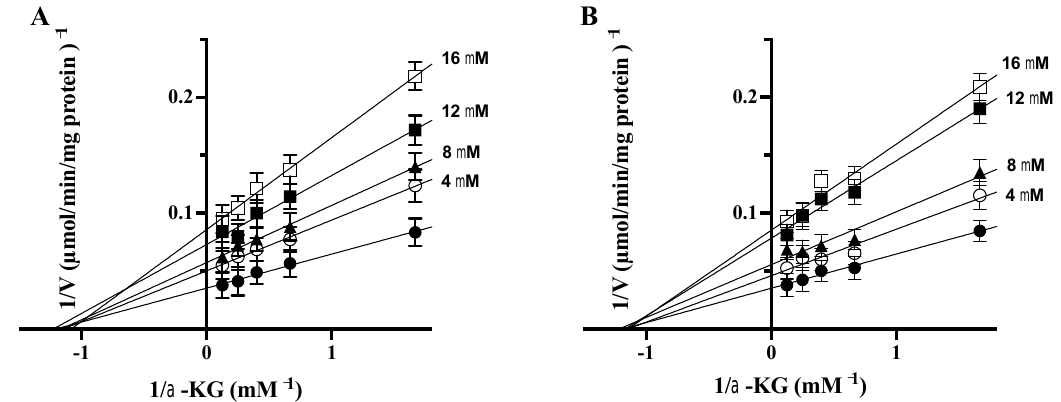
Figure 5. Lineweaver–Burk plot reporting the purified bovine liver GDH activity at the indicated concentrations of α -KG in the absence ( ● ) or in the presence of 4( ○ ), 8 ( ▲ ), 12 ( ■ ), and 16 ( □) μM of PAA ( A ) and quercetin ( B ). The values shown are the means ± SD for three independent measurements.